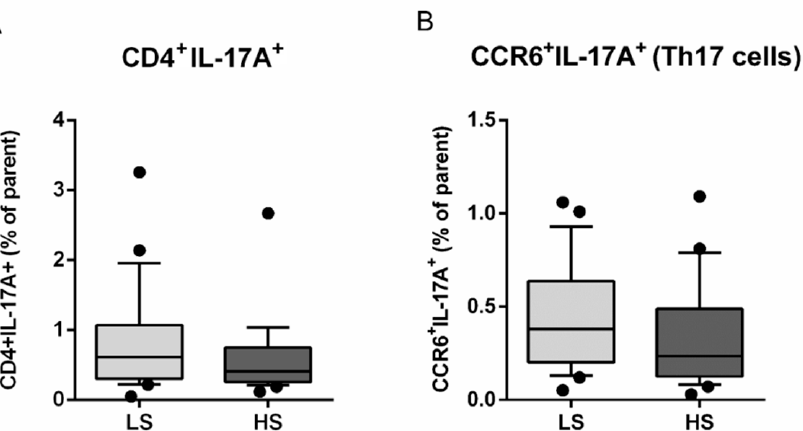
Figure 4. Effects of a 7 ‐ day high ‐ salt diet on the representation of peripheral Th17 population in healthy young individuals. Relative frequencies of total IL ‐ 17 ‐ secreting peripheral T helper (CD3 + CD4 + ) cells are shown at panel ( A ), while the relative frequencies of CCR6 + IL17 + T cells, corresponding to Th17 cells, are demonstrated at Panel ( B ). Data are presented as box ‐ and ‐ whisker plots 10 to 90 percentiles. Paired t ‐ test, LS vs. HS; p < 0.05 was considered significant.